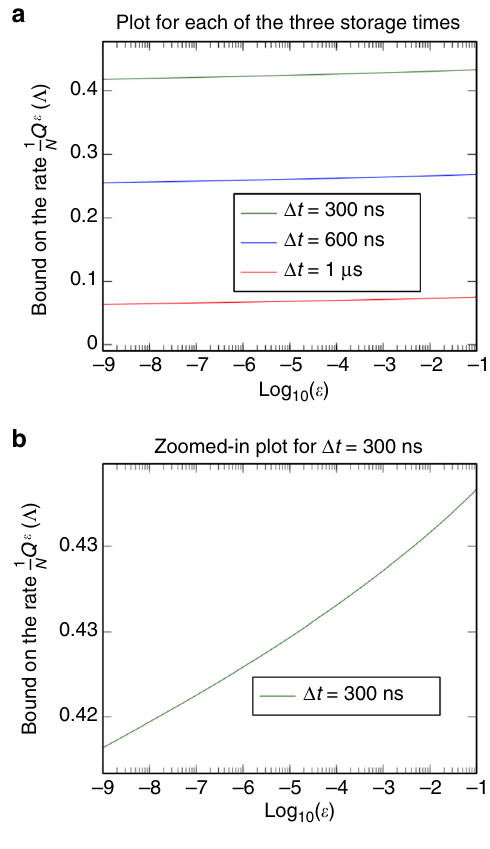
Fig. 3 Bound on the rate for the experimental data as a function of ε . This fi gure shows the bound on the one-shot quantum capacity rate for the data gained in the transmon qubit. We pick p = 1/2, and use q = 0.9 as preparation quality to account for the experimental imperfections (see Supplementary Note 7 for details). a The experiment was carried out three times with different storage times Δ t , for each of which we plotted the bound resulting from the estimation protocol as a function of the decoding error probability ε